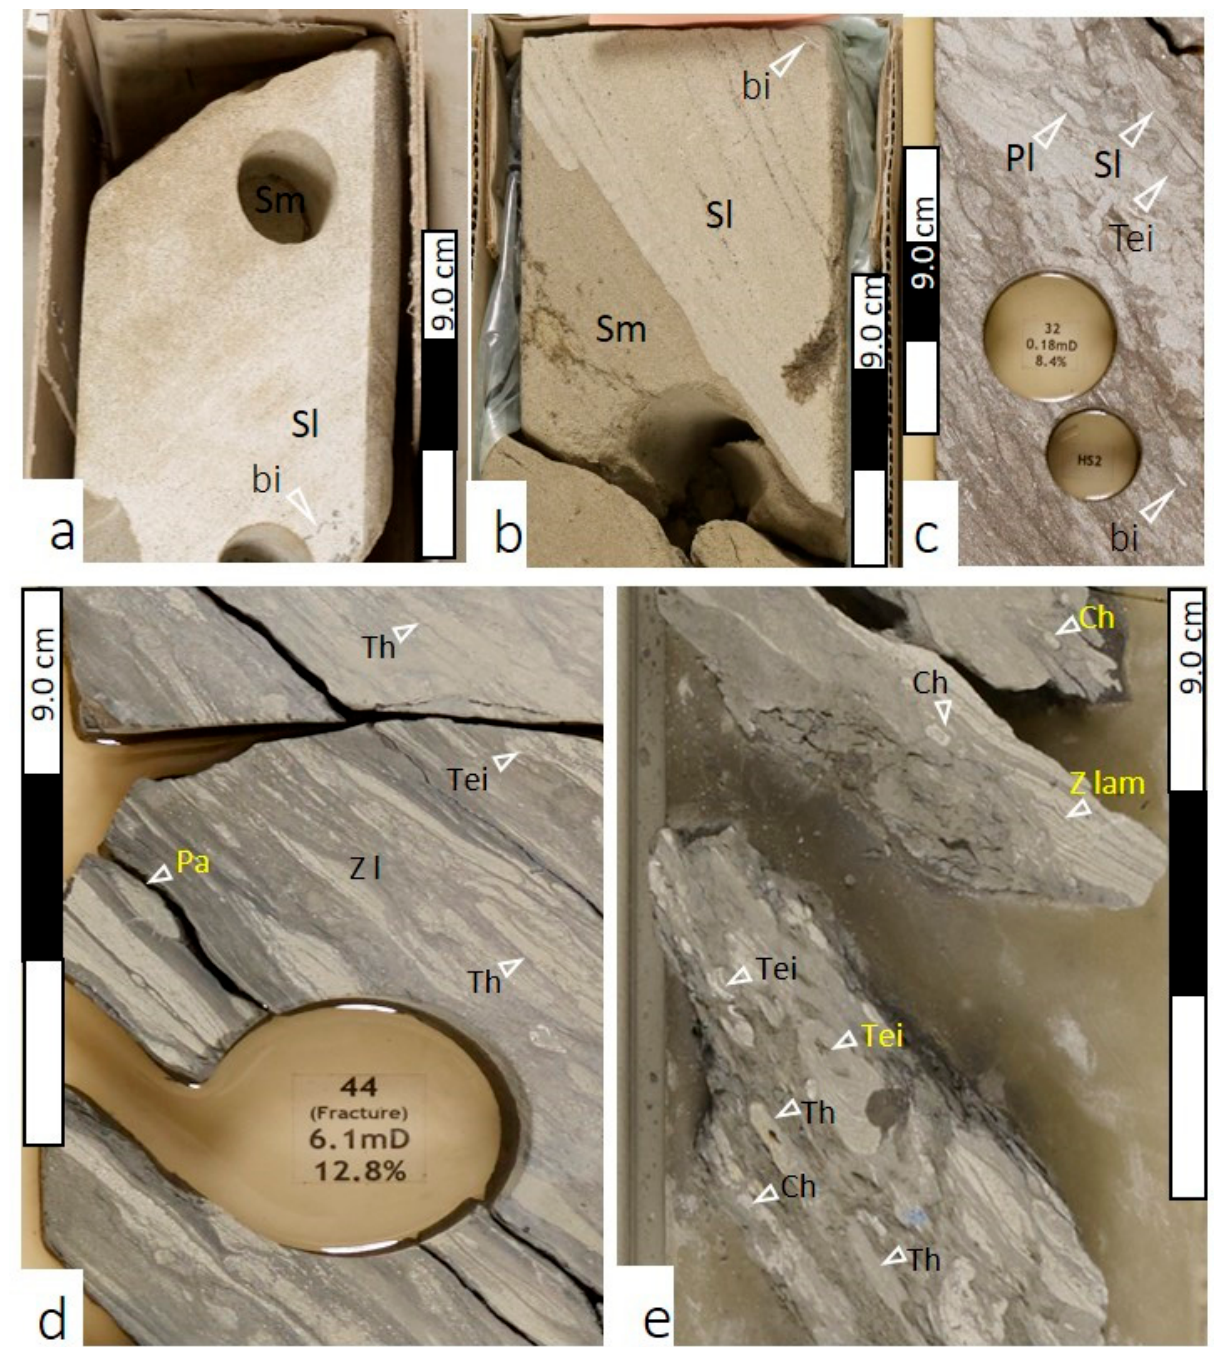
Figure 3. Core photographs of facies associations for the Corallian sandstones. All depths are measured depths (m MD) from core, uncorrected for true vertical depth. ( a ) PW3 (1090.6–1090.7 m MD) showing a foreshore sandstone. ( b ) is an upper shoreface sandstone from PW7 (1135.2–1135.4 m MD) ( c ) BL5 (2195.9–2196.1 m MD) is a proximal lower shoreface sandstone. ( d ) BL5 (2199.4–2199.47 m MD) is a distal lower shoreface sandstone. ( e ) PW3 (1096.8–1096.9 m MD) shows